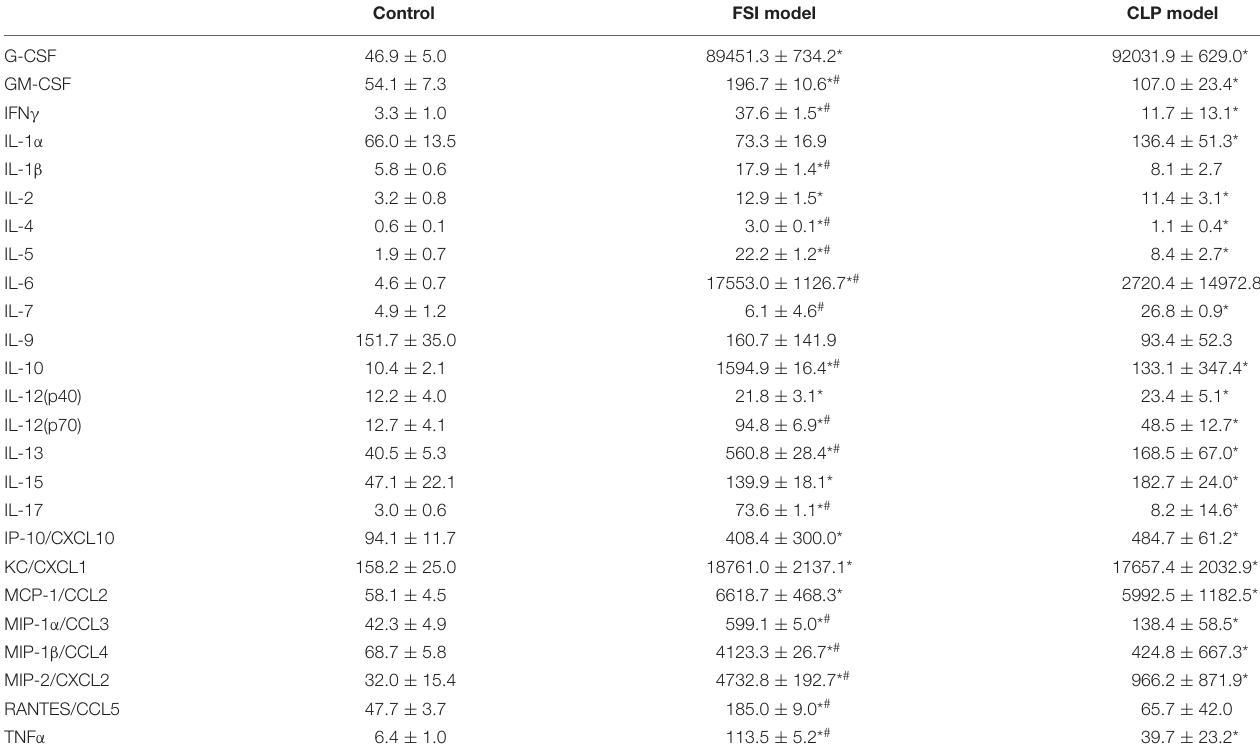
TABLE 3 | Cytokine and chemokine measurements performed by multiplex analysis in FSI and CLP models 20 h after onset of